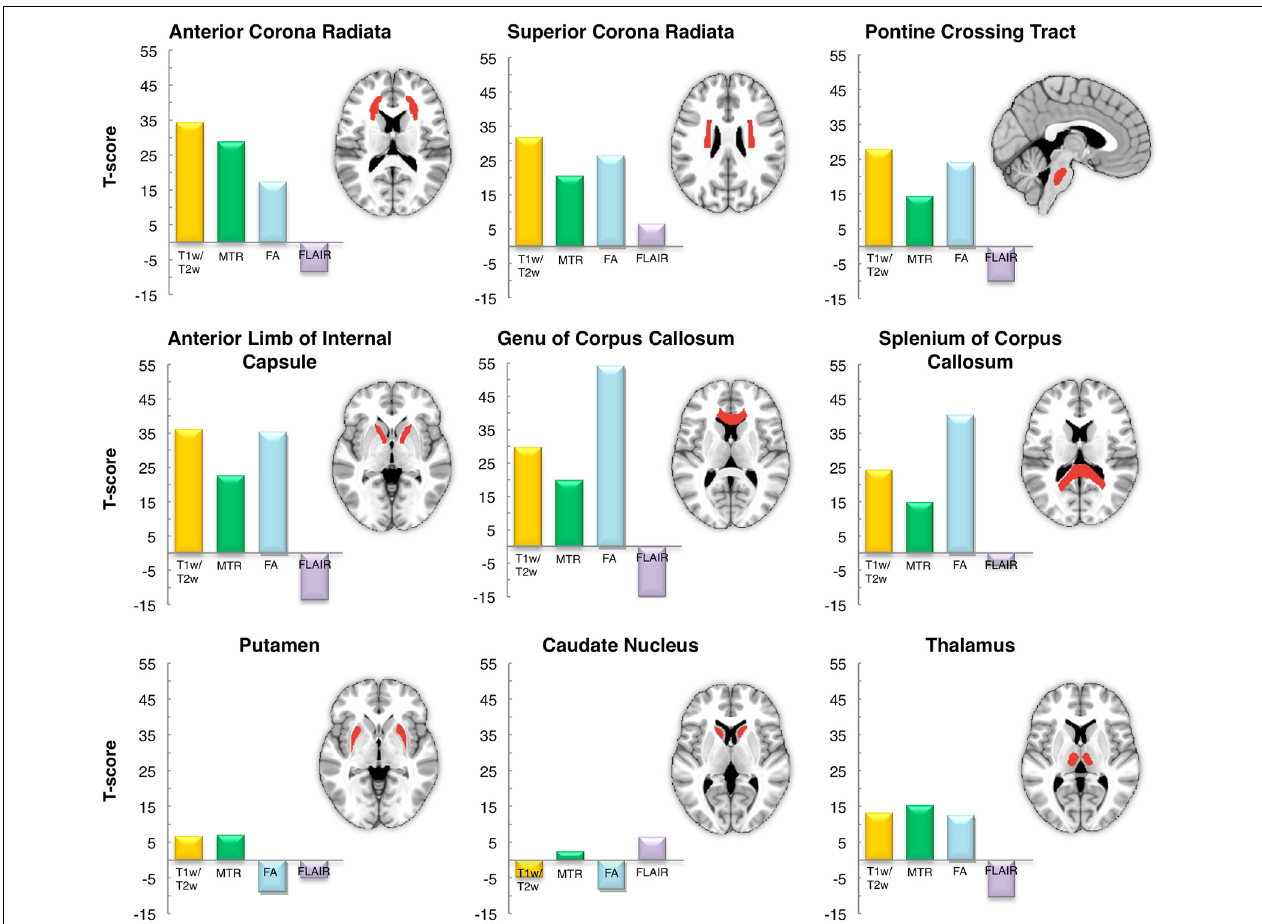
FIGURE 10 | Inter-subject reproducibility: ROI analysis. The across-subject reproducibility of the T1-w/T2-w images as compared to MTR, FA and FLAIR were evaluated on specific ROIs. The analysis was